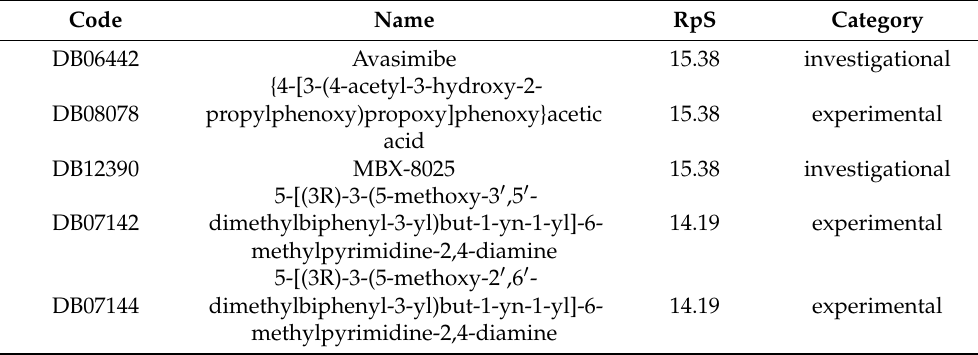
Table 3. The top 20 candidates for repurposing studies based on their RpS score